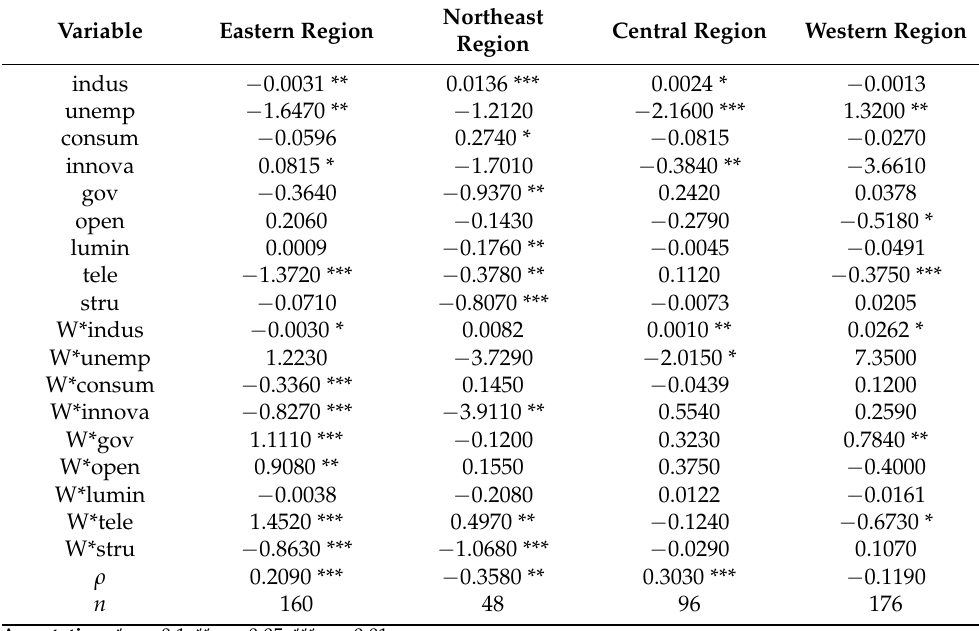
Table 4. Analysis of the relationship between an industrial transfer and well-being considering the regional differences.